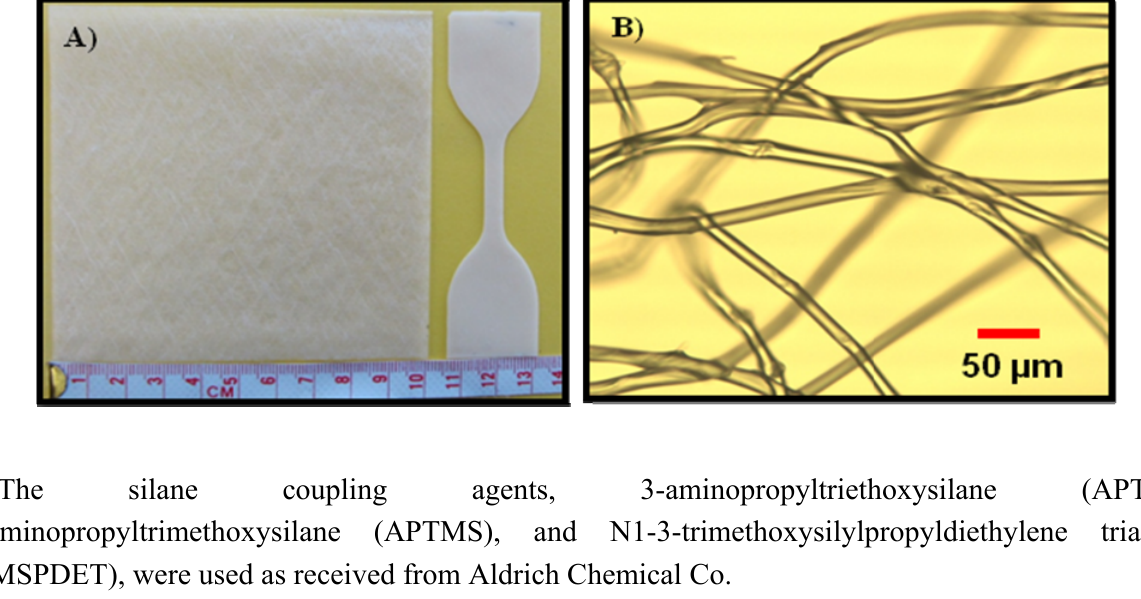
Figure 1. Photograph ( A ) and microphotograph ( B ) of cotton fiber used as the